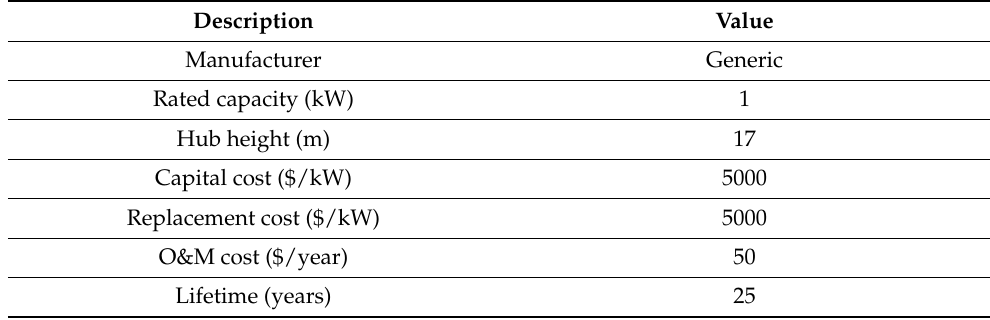
Table 3. Technical specifications of the wind turbine.